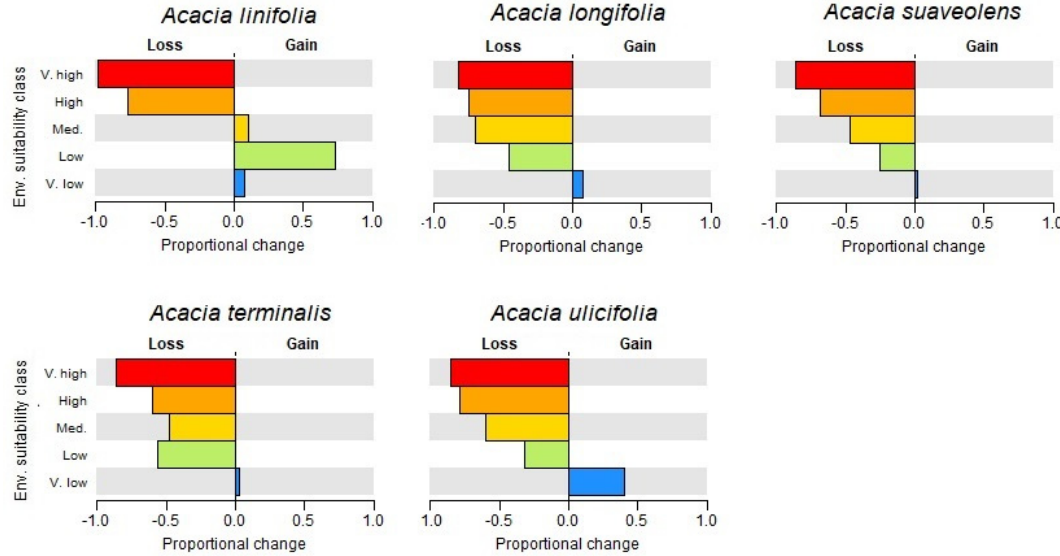
Figure 3. The proportional change (relative to baseline raster bin values) in habitat suitability between current day and 2070 models calculated in MaxEnt for the five Acacia study species.